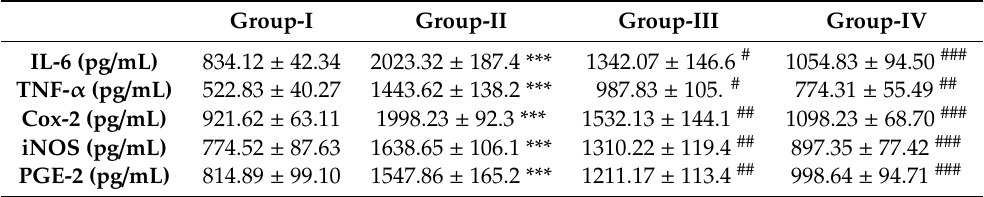
Table 2. E ff ect of Piperine on Serum Levels of Inflammatory Cytokines (IL-6, TNF- α , Cox-2, iNOS and PGE-2).